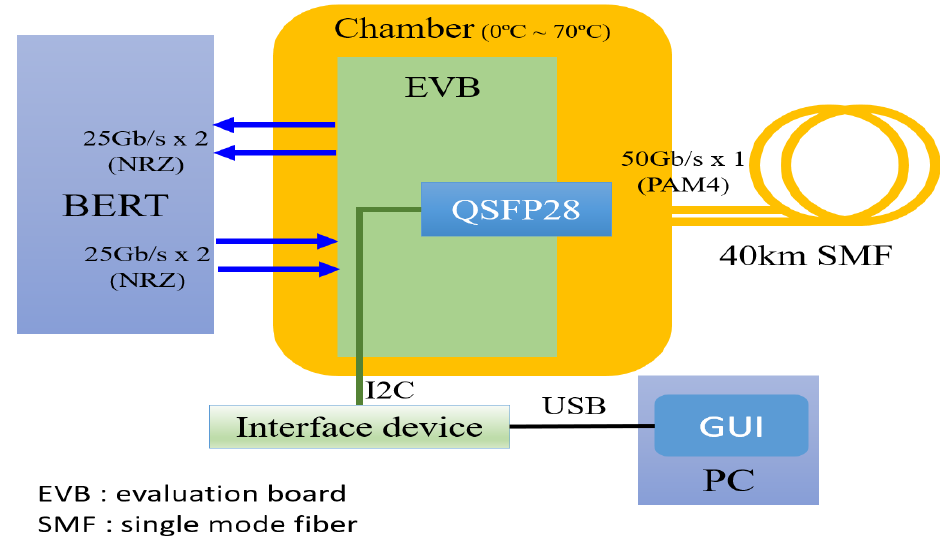
Figure 10. QSFP28 transmission test-bed configuration diagram.